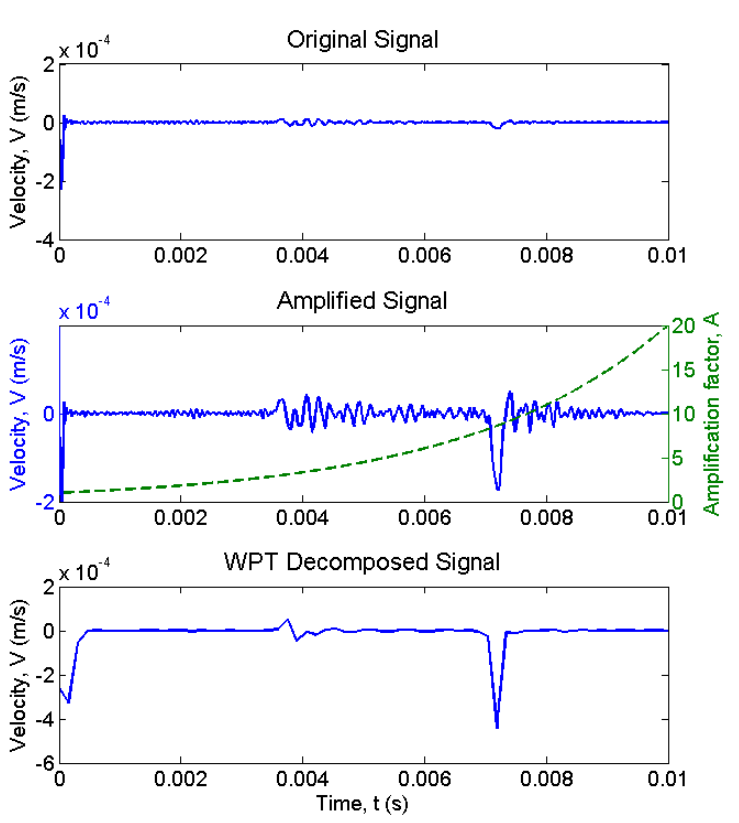
Figure 11. Amplification and WPT decomposition of the signal.